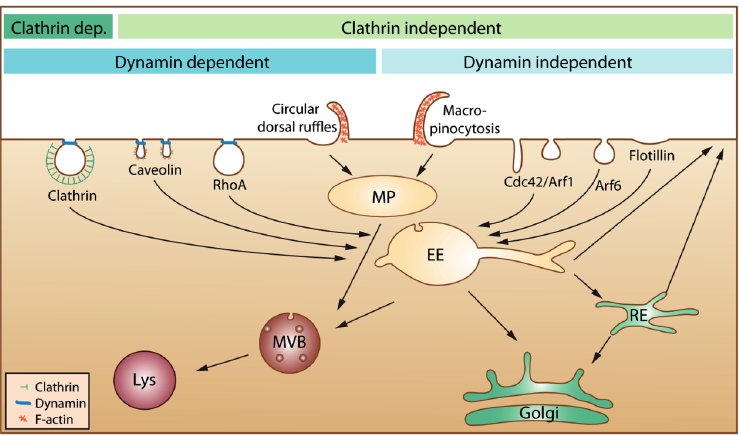
Figure 1. An overview of cellular endocytic mechanisms. The various endocytic uptake mechanisms are presented according to their dependency on either clathrin or dynamin. Most internalized cargo ends up in a common compartment, the early endosome (EE). From EEs, the cargo can either be directly recycled to the plasma membrane or be sorted to the recycling endosome (RE) before returning to the cell surface. Cargo that is not recycled may move down the endo-lysosomal pathway via multivesicular bodies (MVB) for degradation in the lysosome (Lys). Clathrin dep: Clathrin dependent. MP: